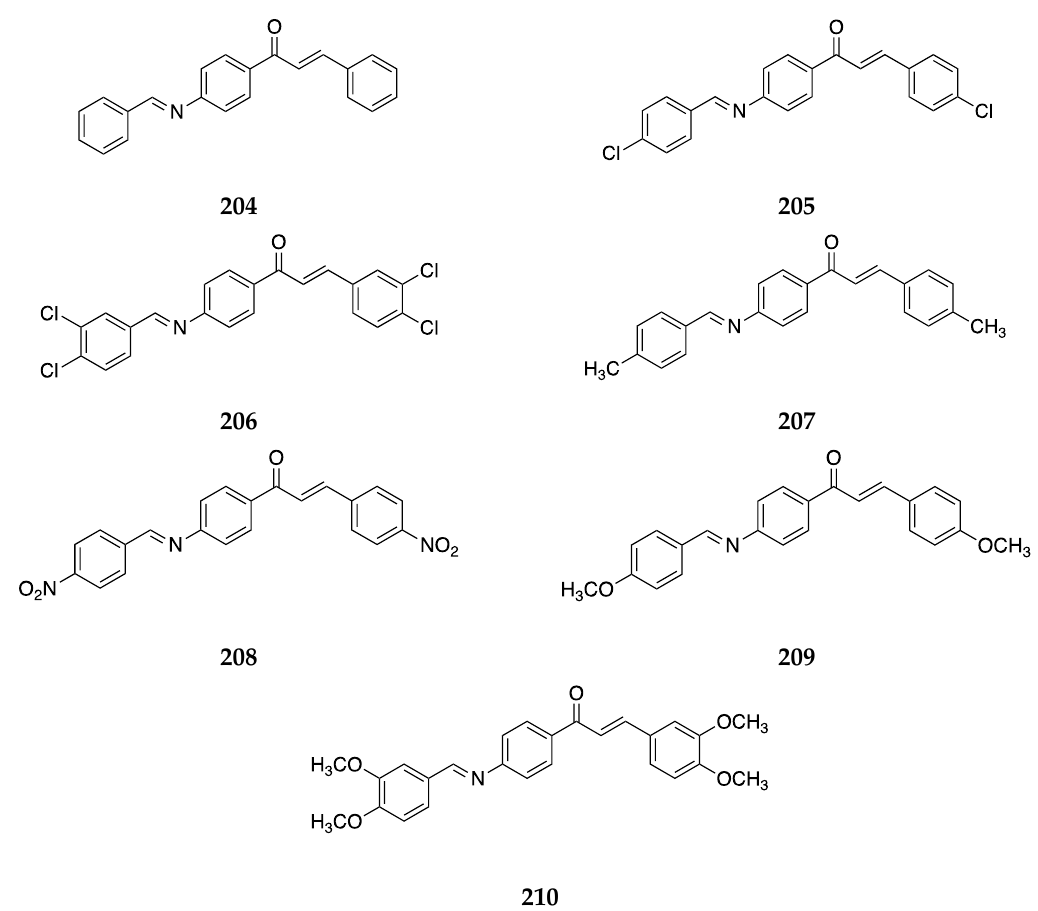
Figure 66. Chemical structures of N -alkenylated 4-aminochalcone derivatives.